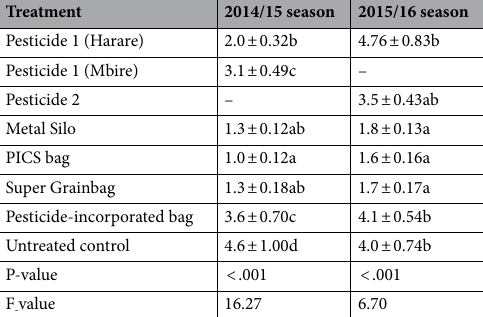
Table 5. Overall treatment effects on sorghum grain weight loss during the 2014/15 and 2015/16 storage seasons in Mbire district, Zimbabwe (n = 40). Means are compared per column, and those which do not share the same letter are significantly different from one using Tukey’s test at 0.05